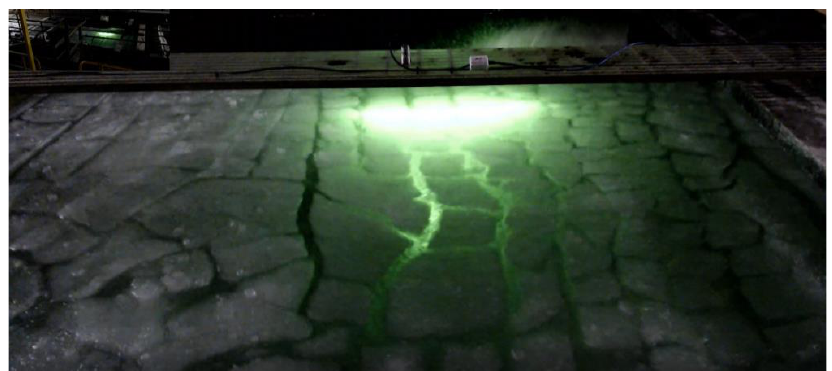
J. Mar. Sci. Eng. 2022 , 10 , x FOR PEER REVIEW Figure 3. View of wave tank surface in the middle of a test. Figure 3. View of wave tank surface in the middle of a test. Table 2. Experiment details.